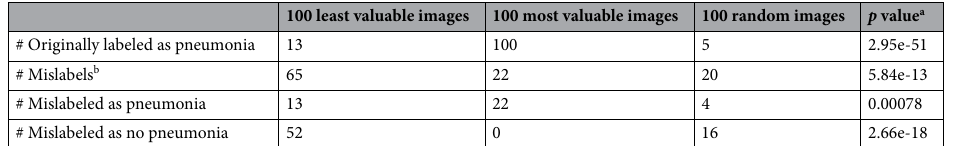
Table 2. Three radiologists’ relabeling results for the 100 least valuable, 100 most valuable and 100 randomly sampled chest X-ray images in the training set. We used the majority vote to obtain the final label of each image. Disagreed images were excluded from further analyses. There were many more mislabeled examples in low value images (i.e. 65) than high value images (i.e. 22, pairwise p = 8.61e-10) or random images (i.e. 20, pairwise p = 1.22e-10), suggesting that low Shapley value effectively captures mislabels in the dataset. a p values 2 computed using χ test. b Note that since our training set has a higher percentage of pneumonia labels, the mislabel rates may not be representative for the entire ChestX-ray14